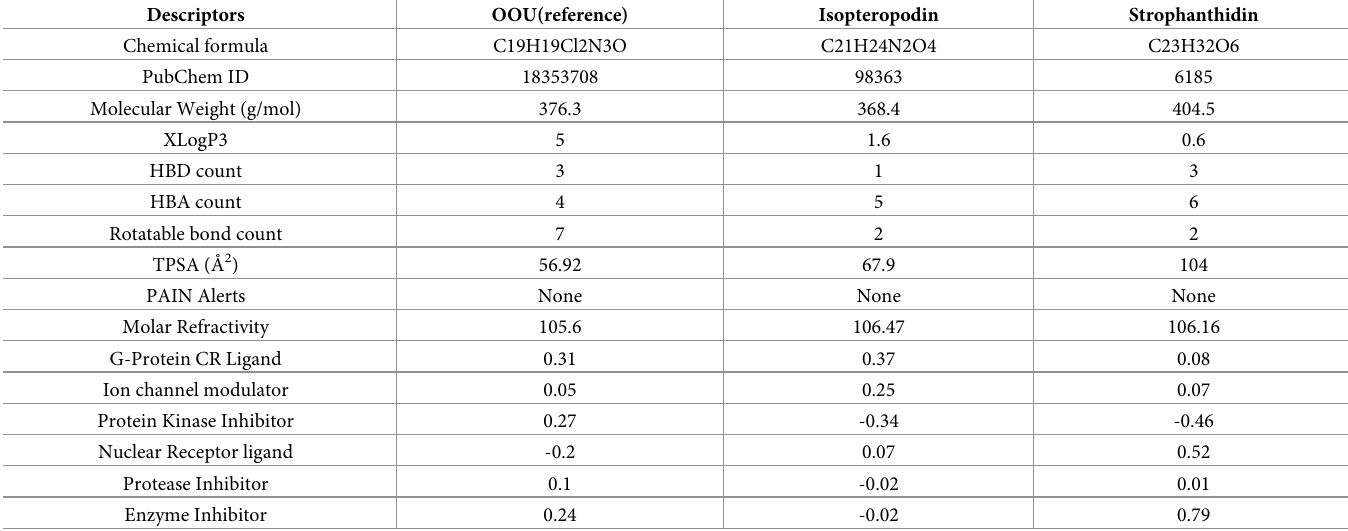
Table 1. Chemical and physical properties of reference and lead compounds.